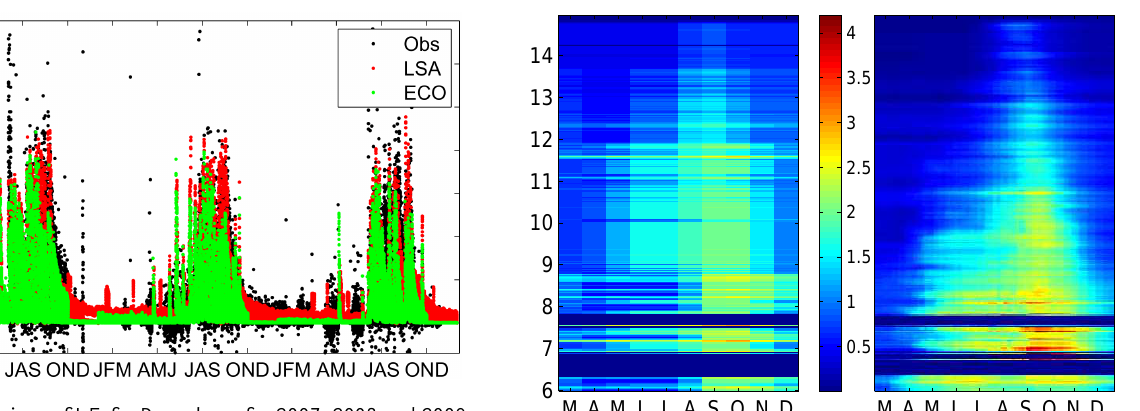
Fig. 9. Comparison of LE for Demokeya for 2007, 2008 and 2009; observed in (Obs: black), simulation using ECOCLIMAP-I (ECO: green), simulation using LSA-SAF LAI (LSA: red).